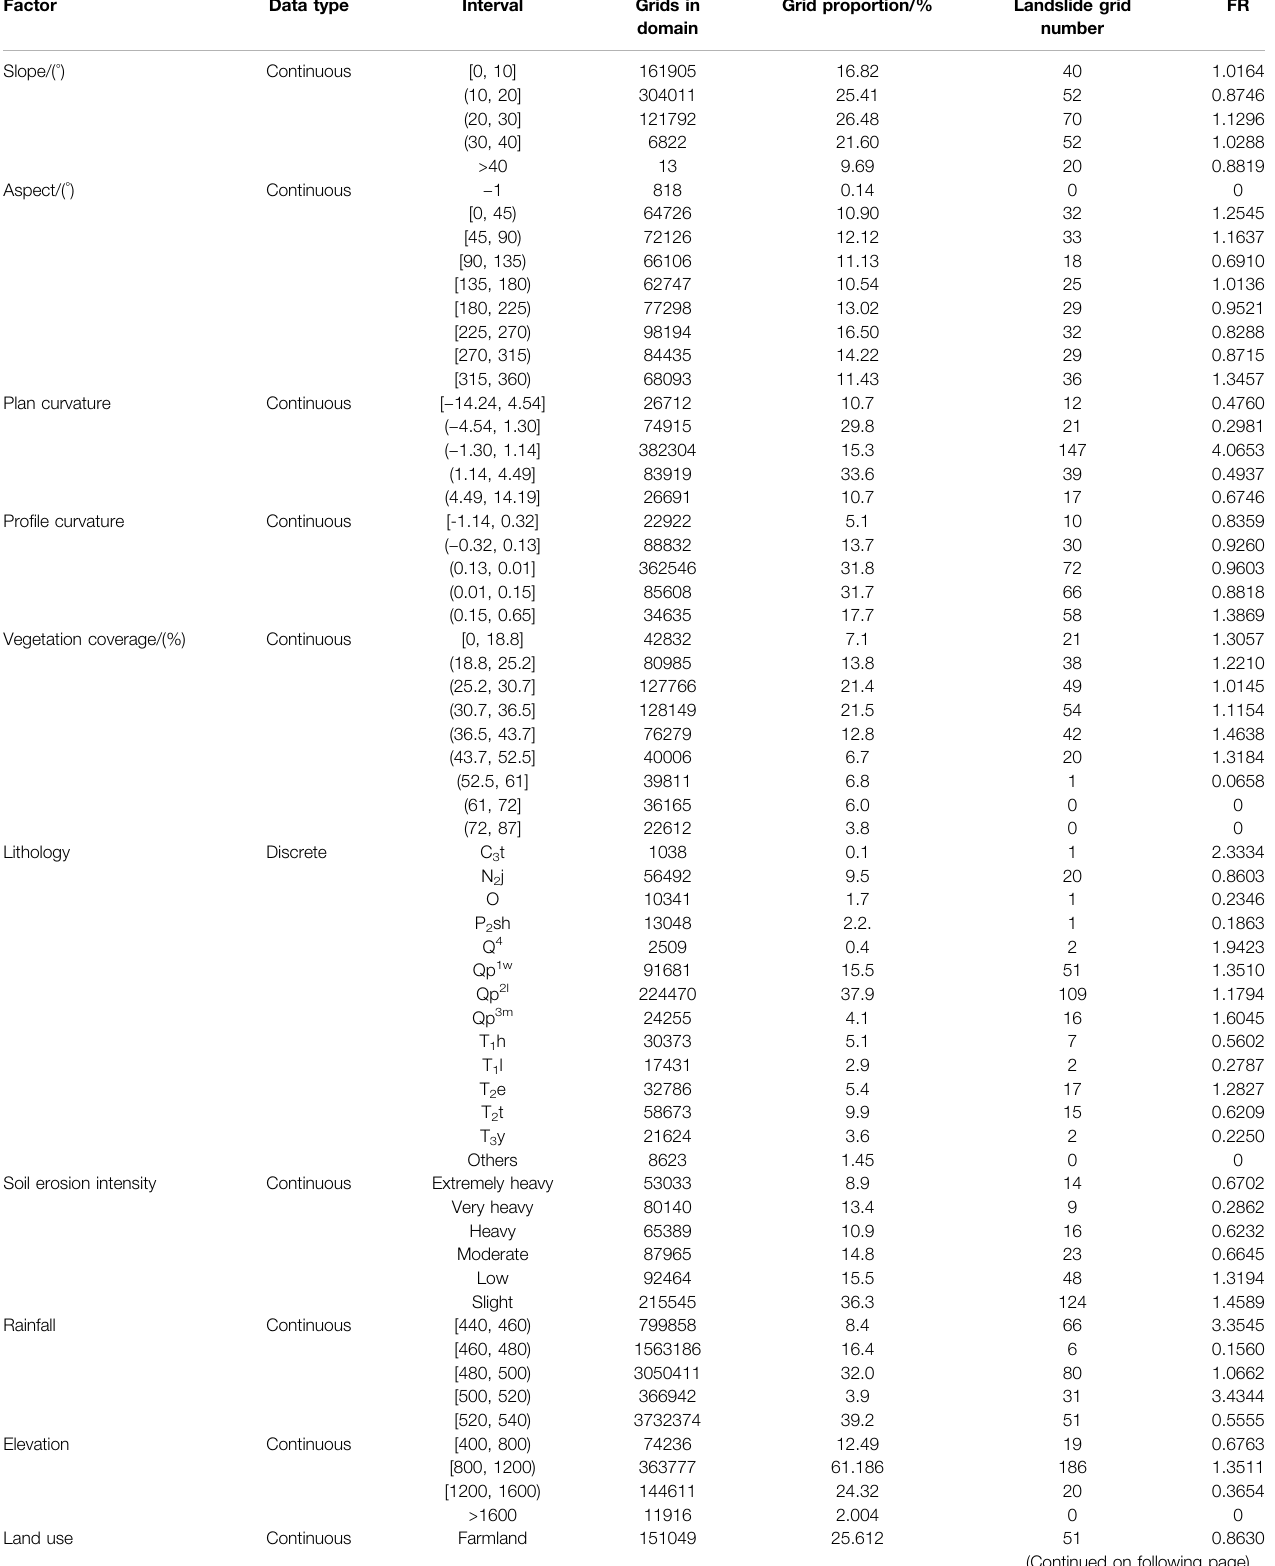
TABLE 2 | Frequency ratios of index